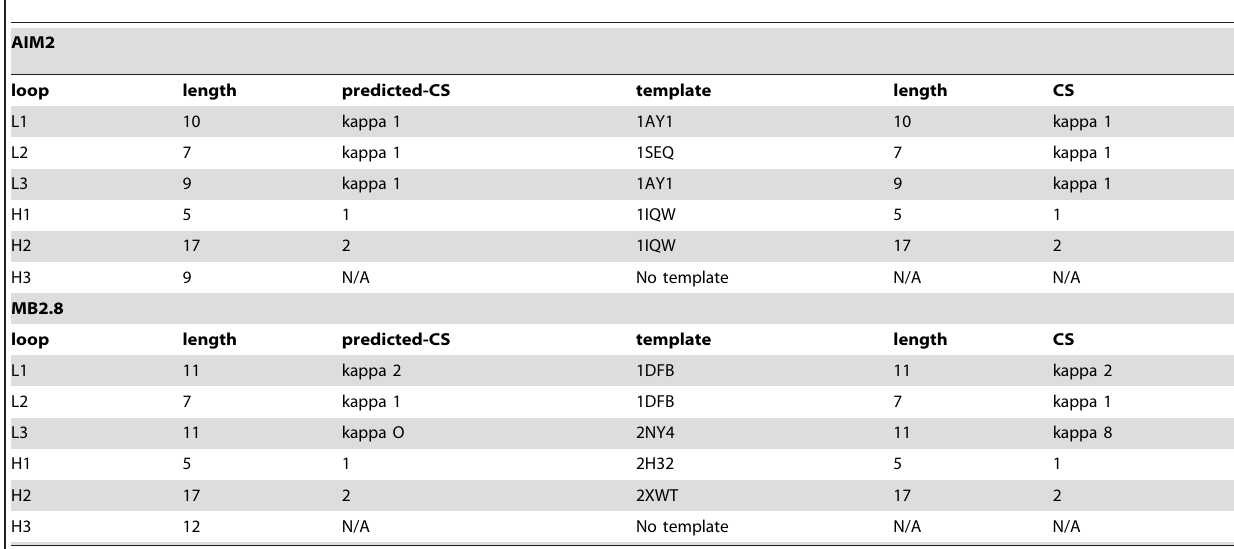
Table 1. Length and canonical structure (CS) of the CDRs in the modelled antibodies and in the corresponding templates.